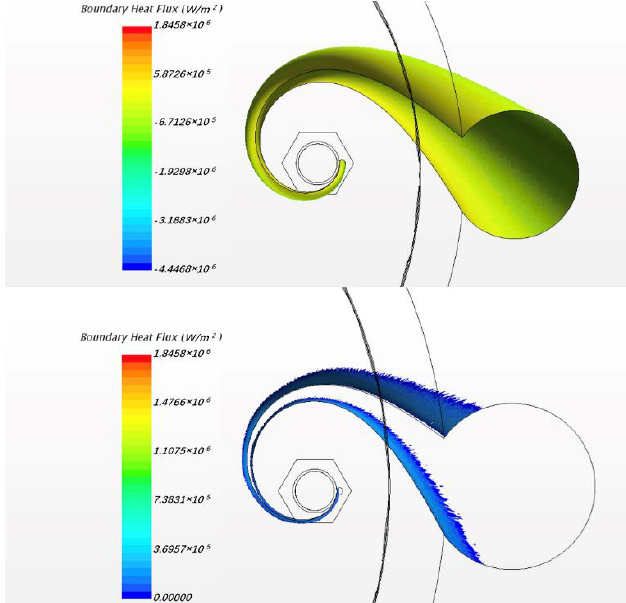
Figure 16. The schematic of heat flux along the wrapping wire surface under solid model.